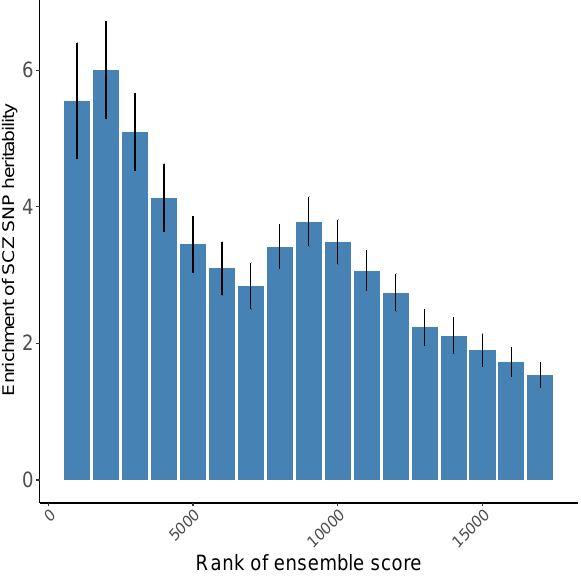
Figure 3. Enrichment of schizophrenia-SNP heritability with the number of ranked genes (calculated using LDSC). The most recent SCZ GWAS results published in 2020 [21] was used in the analysis. Top ranked genes are significantly enriched for SNP-based